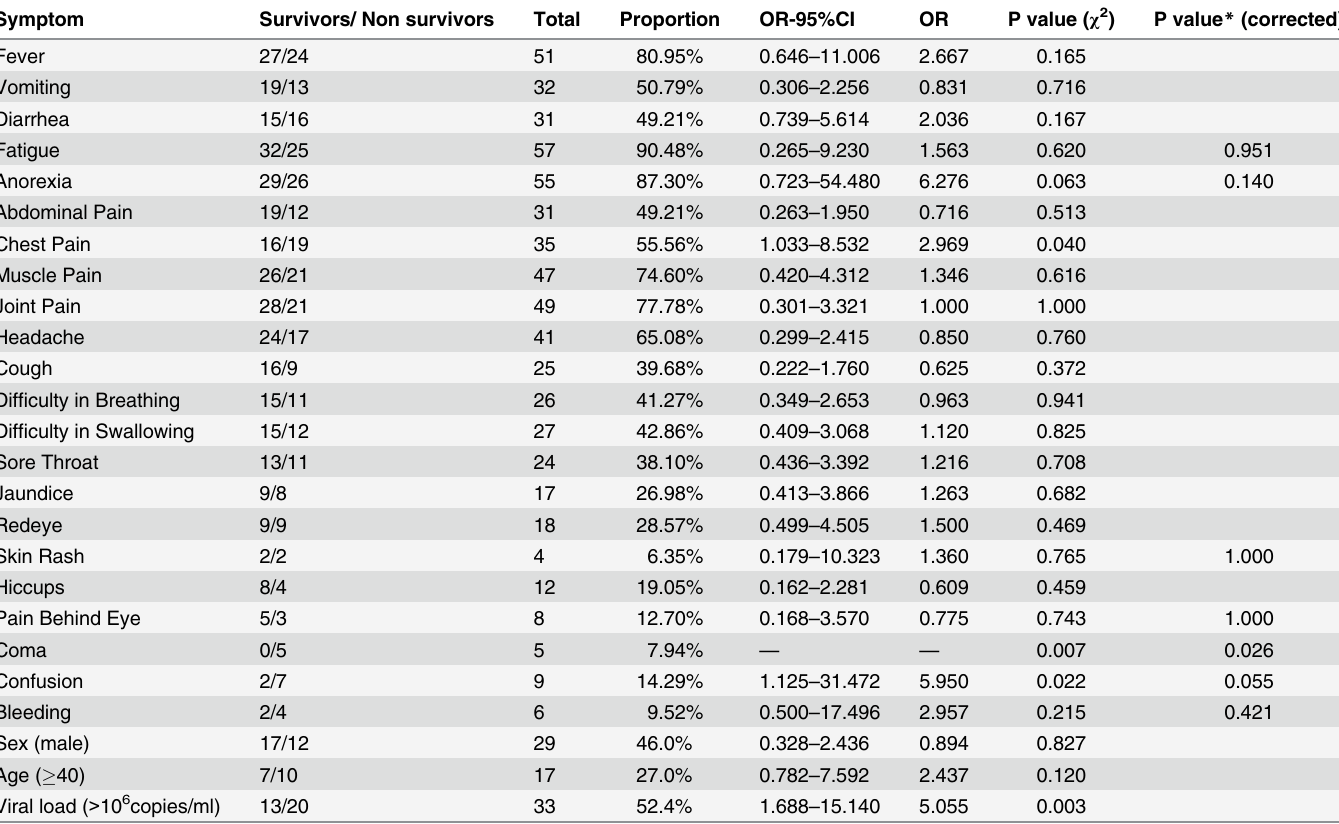
Table 1. Correlation between the symptoms and the prognosis (chi square